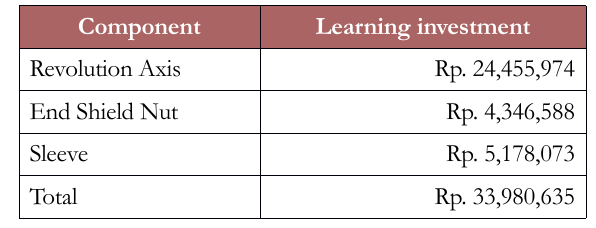
Table 17. Learning investment in manufacturer side